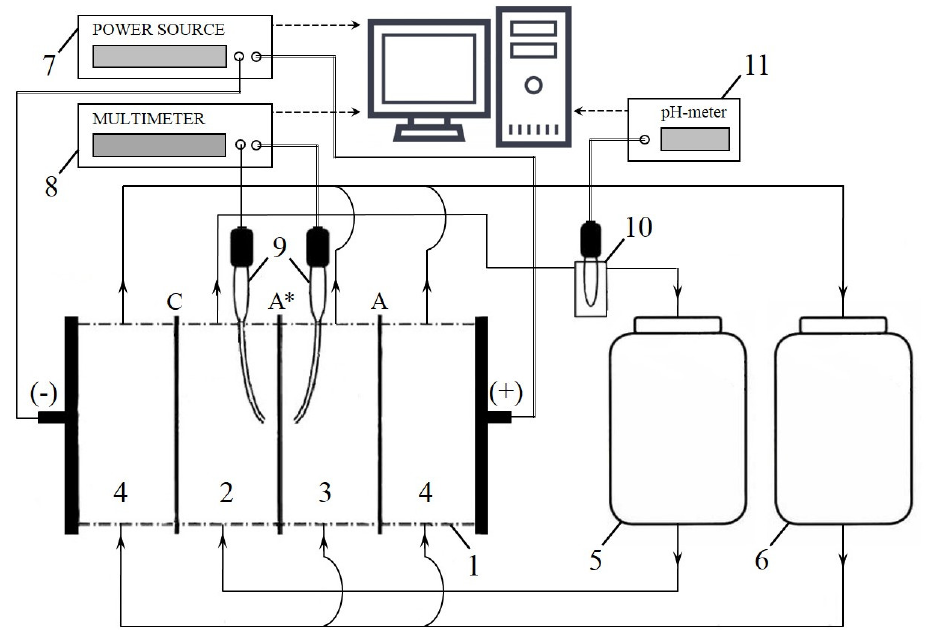
Figure 16. Principal scheme of the experimental setup: electrodialysis cell (1) consisting of desalination (2), concentration (3), and two electrode compartments (4); tanks with solutions (5, 6); programmable power source Keithley SourceMeter 2400 (7); multimeter Keithley 2010 (8); Luggin’s capillaries, connected with silver chloride electrodes (9); flow pass cell with pH combination electrode (10); pH-meter Expert 001 (11).